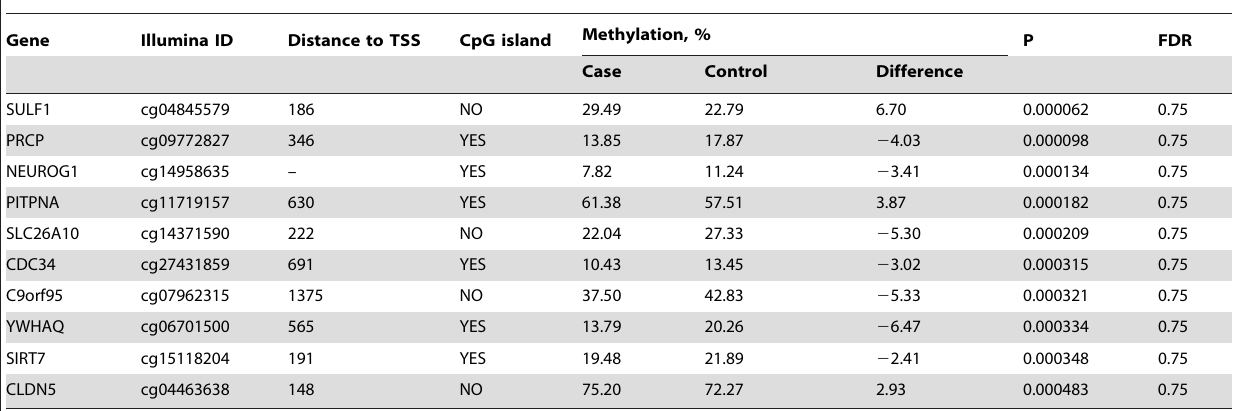
Table 2. Top 10 differentially methylated CpG sites.